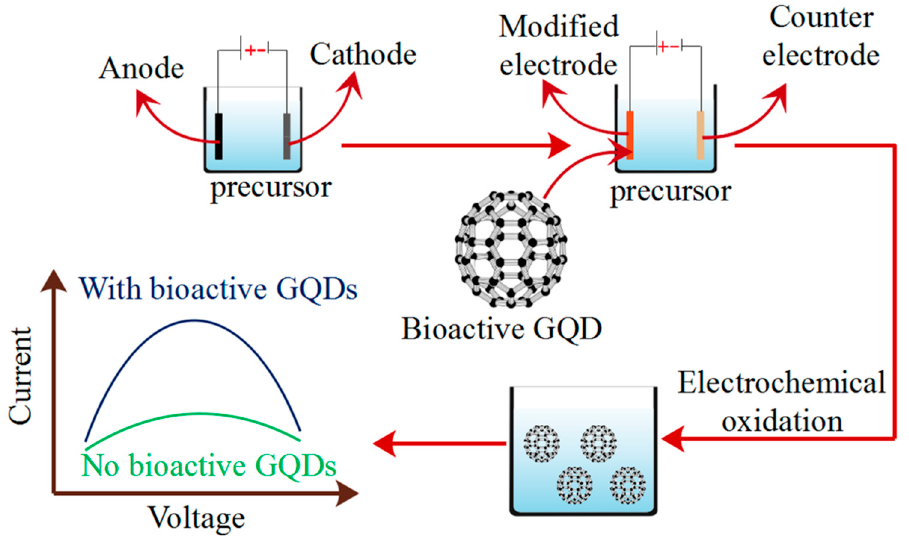
Figure 5. The synthesis method of electrochemical oxidation.